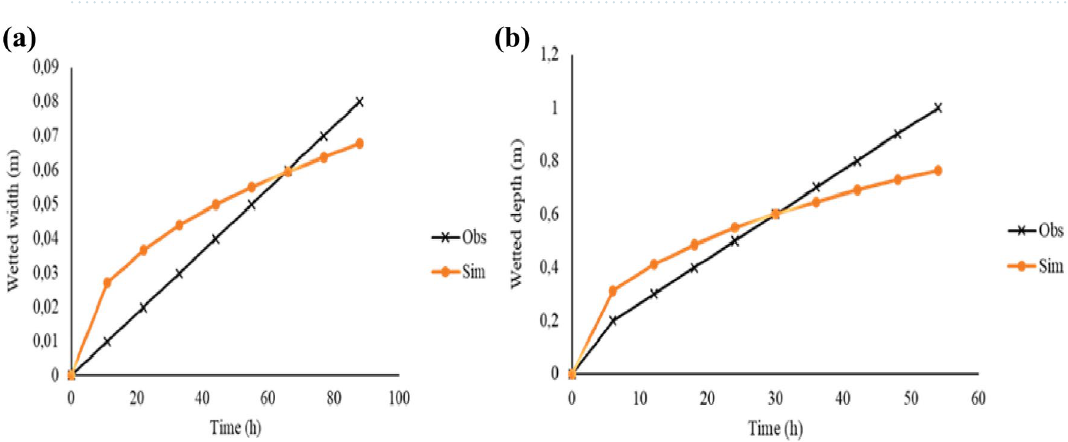
Figure 6. Observed vs simulated wetted distances for sandy soil.